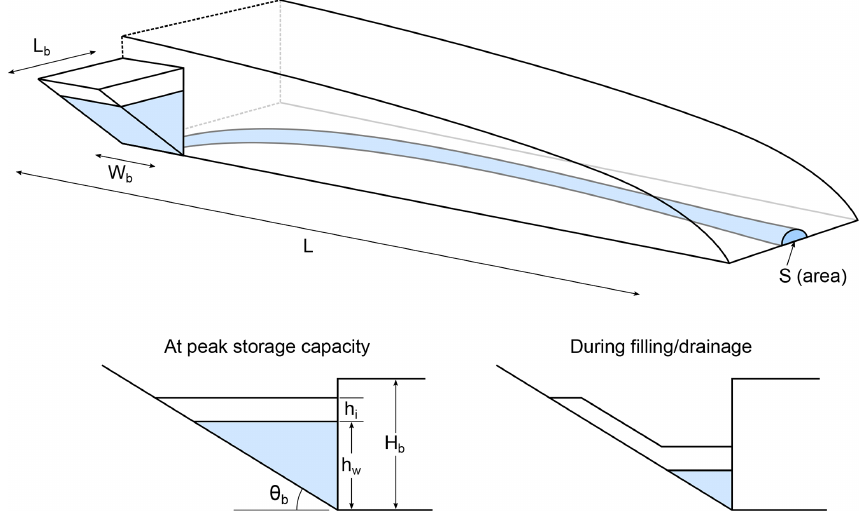
Figure 2. Model schematic illustrating the glacier and basin geometry (for a wedge-shaped